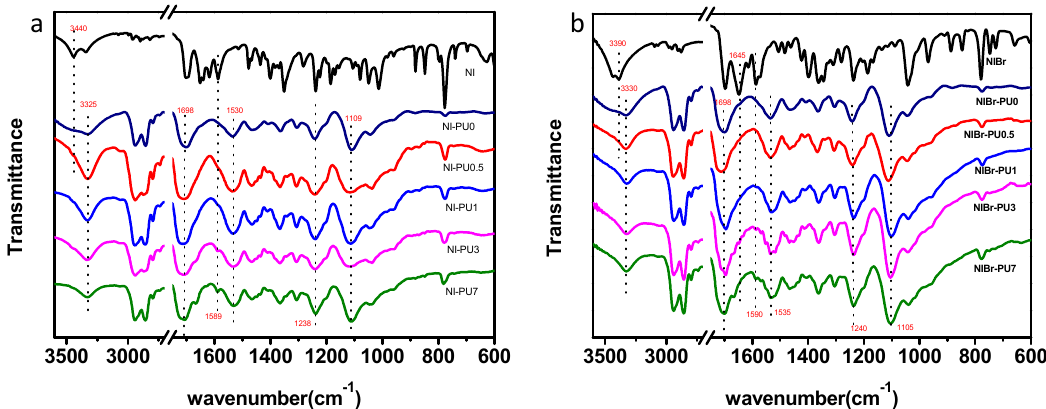
Figure 1. FTIR spectra of NI-PU ( a ) and NIBr-PU ( b ) films with different dye ratios (e.g., NI-PU1 means 1% NI by weight in WPU).